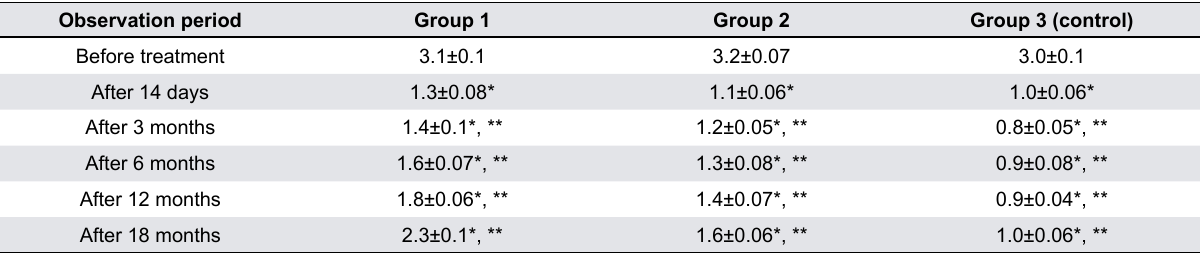
Table 5- The dynamics of the Svrakov number